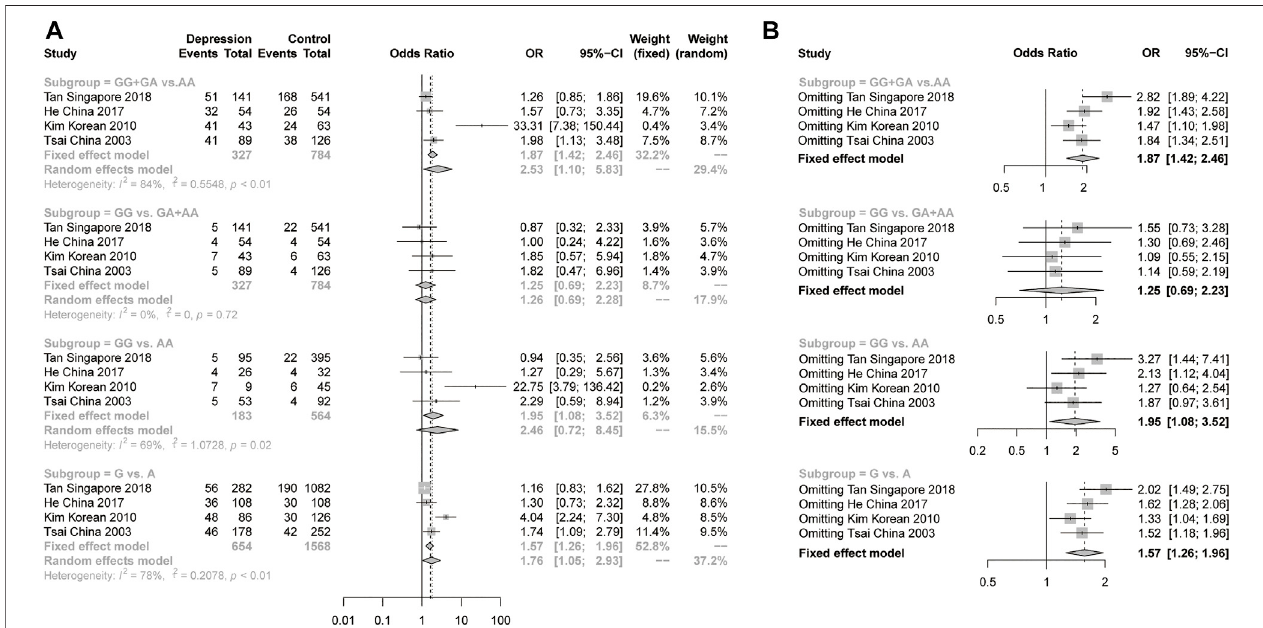
FIGURE4|(A) ,Forestplotofstudiescomparingthedistributionofthers9340799polymorphismofER α betweenwomenwithdepressionandcontrolsintheAsian subgroup. (B) ,Thesensitivityanalysisofthestudiespooledinthemeta-analysisofrs9340799polymorphismandwomenwithdepressioninAsiansubgroupbyomitting one study at a